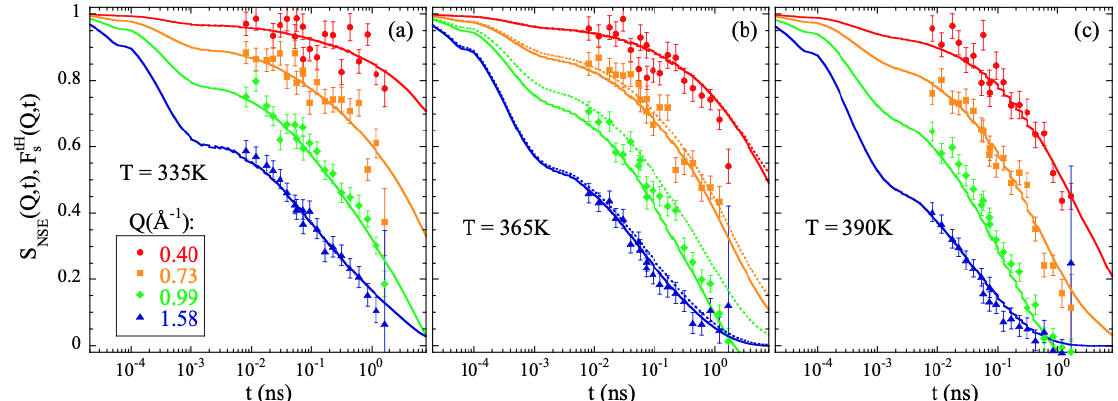
Figure 1. Comparison of the neutron spin echo results obtained from measurements on a fully hydrogenated PIB sample [13] (symbols) and calculated from the simulations (solid lines) at 335 K ( a ), 365 K ( b ) and 390 K ( c ) at the Q -values indicated in ( a ). Bandpass corrections have been applied to the experimental data (see, e.g., [19]). The value considered for the band pass time was 0.2 ps. For comparison, the F s ( Q , t ) calculated for all hydrogens at 365 K is shown by the dotted lines in ( b ).